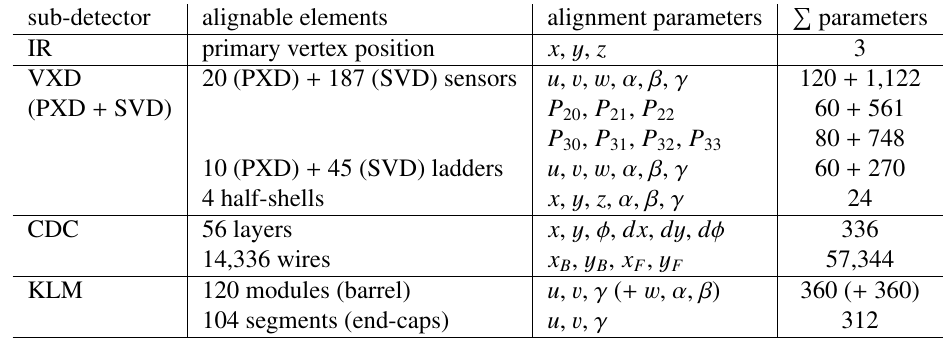
Table 1: The sub-detectors of the Belle II detector, their alignable elements and correspond- ing alignment parameters which are integrated in the common alignment